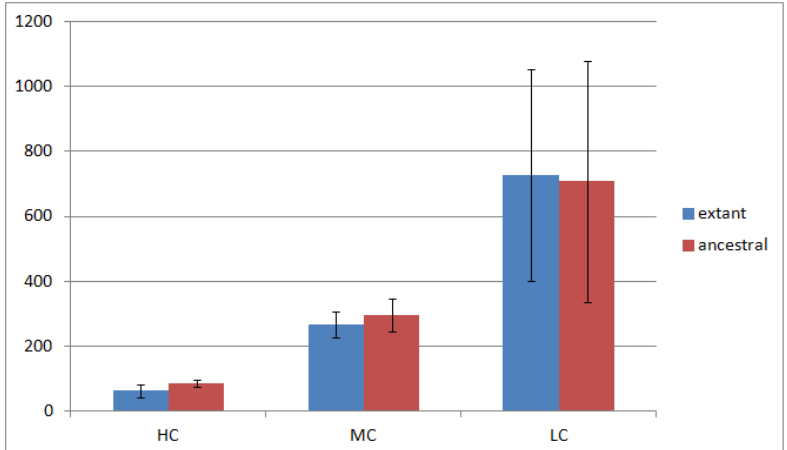
Figure 2. Number of operon gene pairs in extant and ancestral genomes. The error bars represent standard deviation.